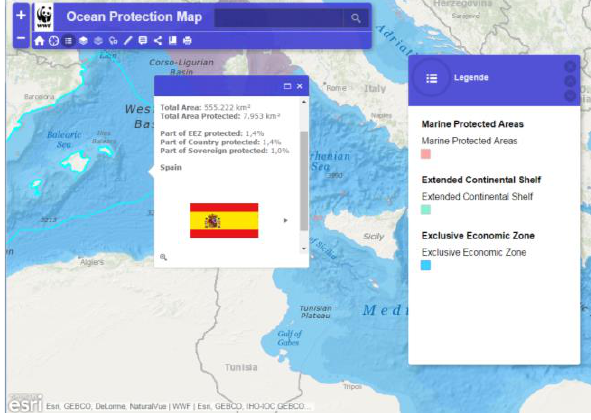
Figure 2. Ocean Protection Map allows users to query how